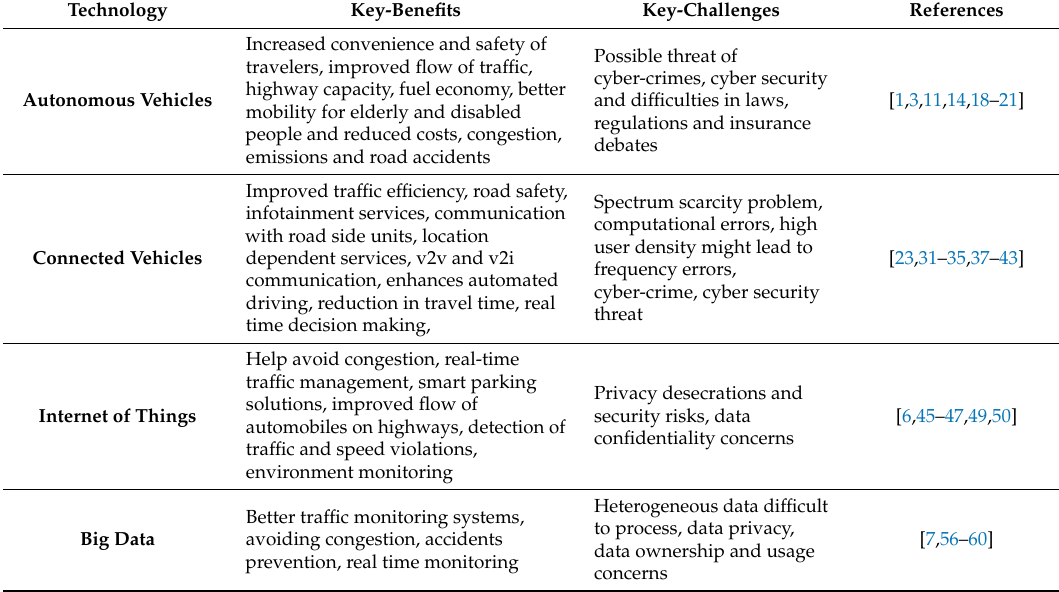
Table 1. Key-benefits and challenges of innovative